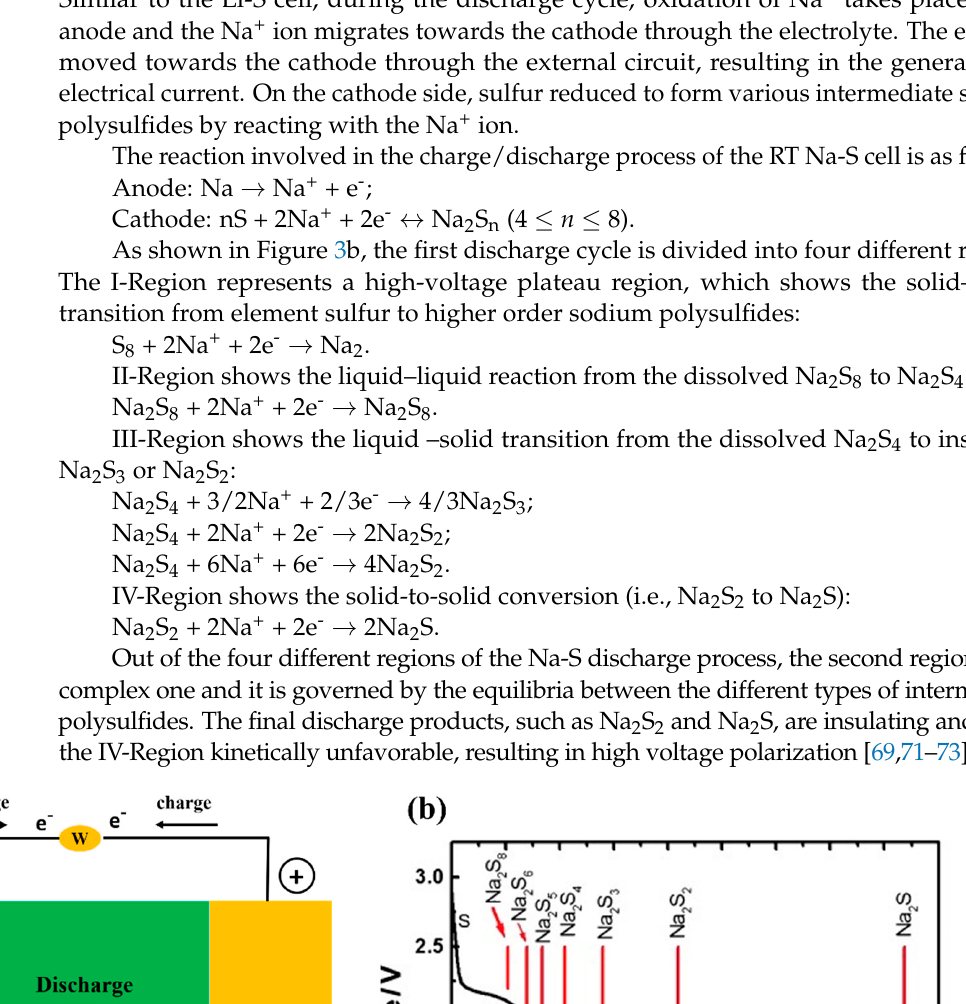
( b ) typical discharge profile of RT Na/S battery. (Reprinted with permission from [69,73]; Copyright